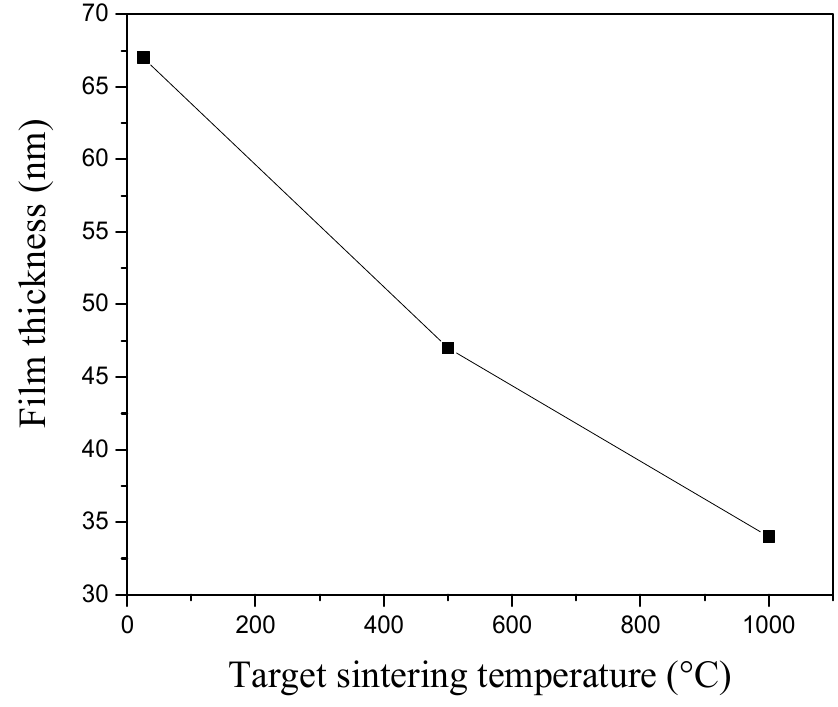
Figure 1. Target sintering temperature influence on thin-film thickness. Scanning electron microscopy micrographs of TiO 2 samples grown on ITO